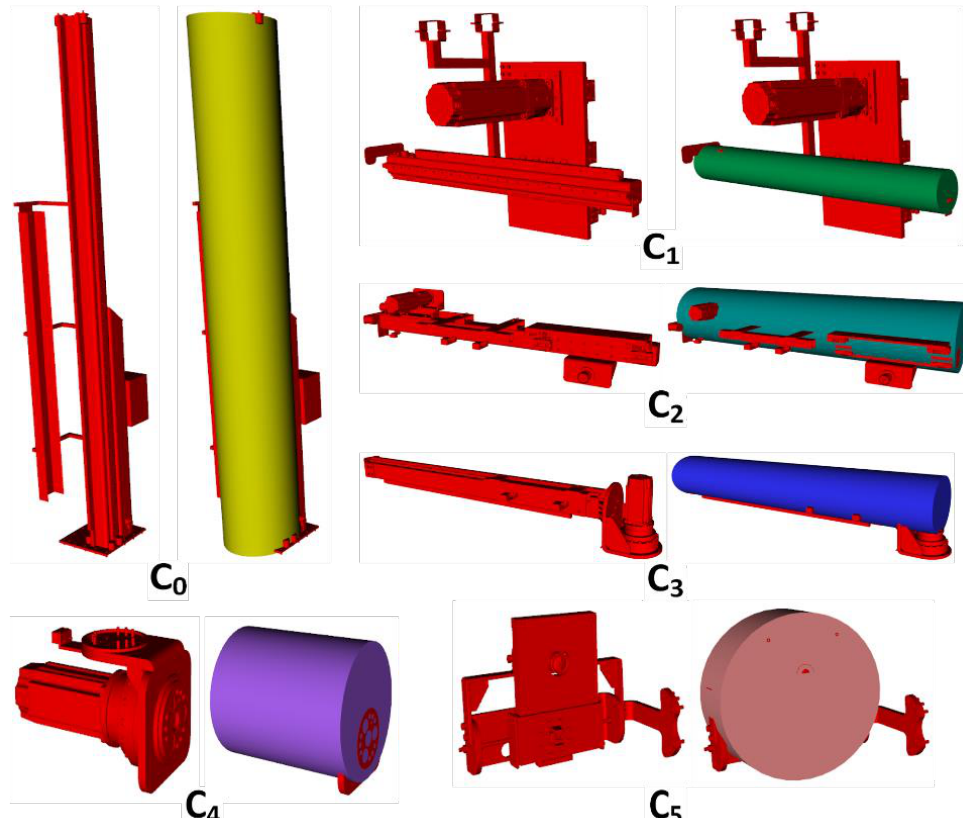
Figure 13. Links of the robot and its related cylinder representations.